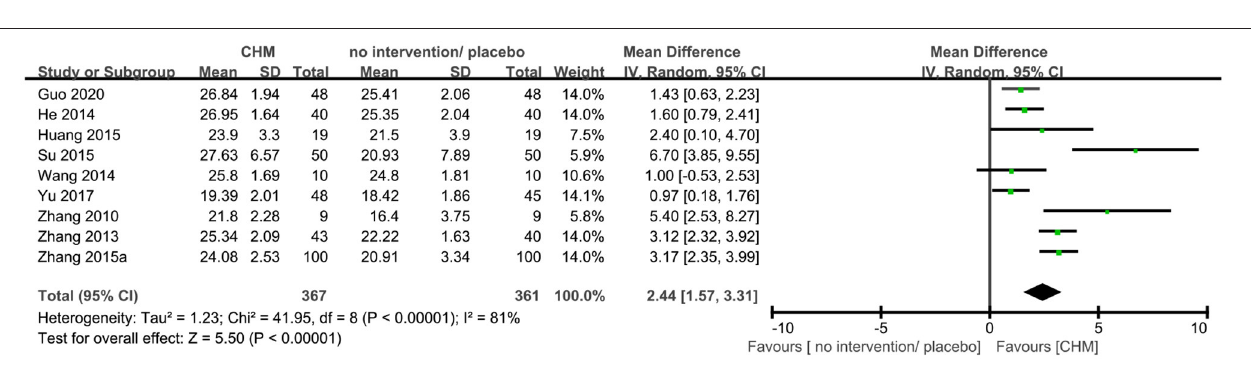
FIGURE 6 | Forest plot of comparison: CHM vs. no intervention/placebo, outcome: MoCA.